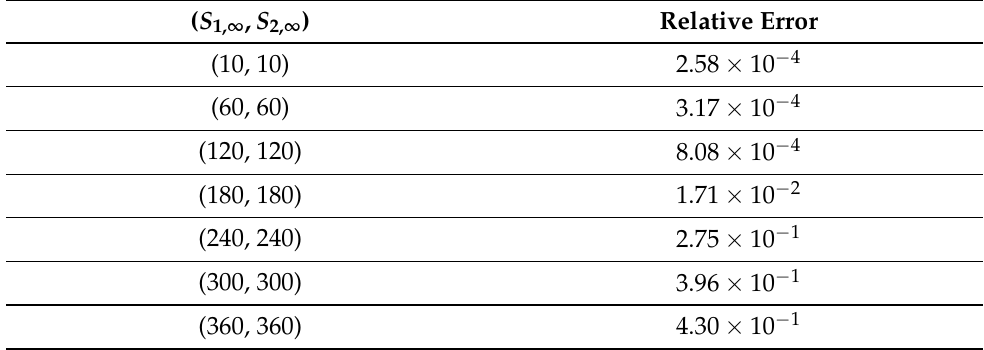
Table 1. Relative error for different